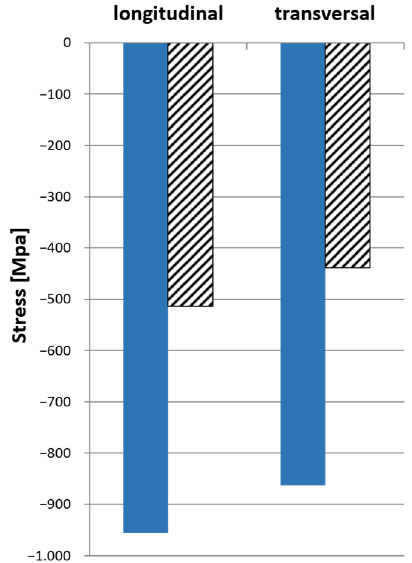
Figure 18. Comparison of residual stresses on external surface for nitride (blue bars) and not nitride (black hatched bars) specimen obtained by XRD. Figure 18. Residual stress in the nitriding zone at different depth levels.